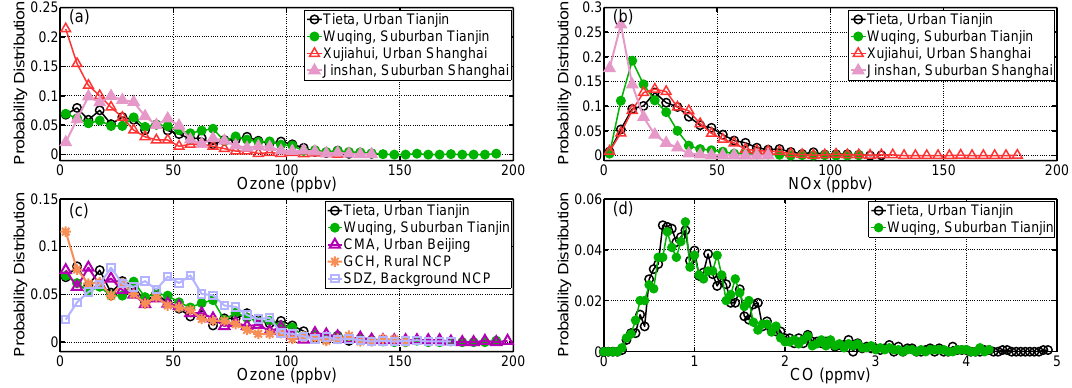
Fig. 2. Probability distributions of (a) ozone and (b) NO x (both 5ppbv per bin) in summer at the four sites; (c) ozone at five sites in summer 2009 in the NCP (5ppbv per bin); (d) CO at both sites in Tianjin (0.05ppmv per bin).